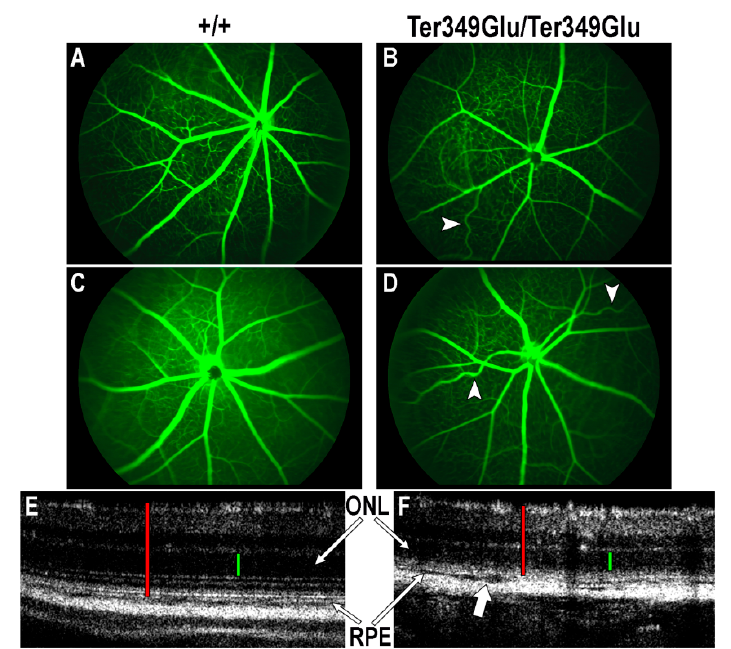
Figure 2. Ter349Glu rhodopsin knock-in mouse retina exhibits both vascular and laminar abnormalities. ( A – D ) Utilizing fluorescein angiography (FA), the state of the retinal vasculature of 4-week-old +/+ ( A , B ) and Ter349Glu / Ter349Glu ( C , D ) mice was examined. Abnormal phenotypes varied in severity among mice, with overall attenuated retinal vessels and tortuous retinal vessels (arrowheads) being commonplace amongst all mice examined. ( E , F ) Optical coherence tomography (OCT) was used to examine the retinas of 4-week-old +/+ ( E ) and Ter349Glu / Ter349Glu mice ( F ) for architectural abnormalities. Ter349Glu / Ter349Glu mice exhibited thinning of the outer nuclear layer (ONL) and patches of varying degrees of separation among the choroid, retinal pigment epithelium (RPE), and photoreceptors (block arrow), indicative of edema. Retinal thickness (red calipers) = 240 µ m ( E ) and 180 µ m ( F ); ONL (green calipers) = 60 µ m ( E ) and 50 µ m ( F ).